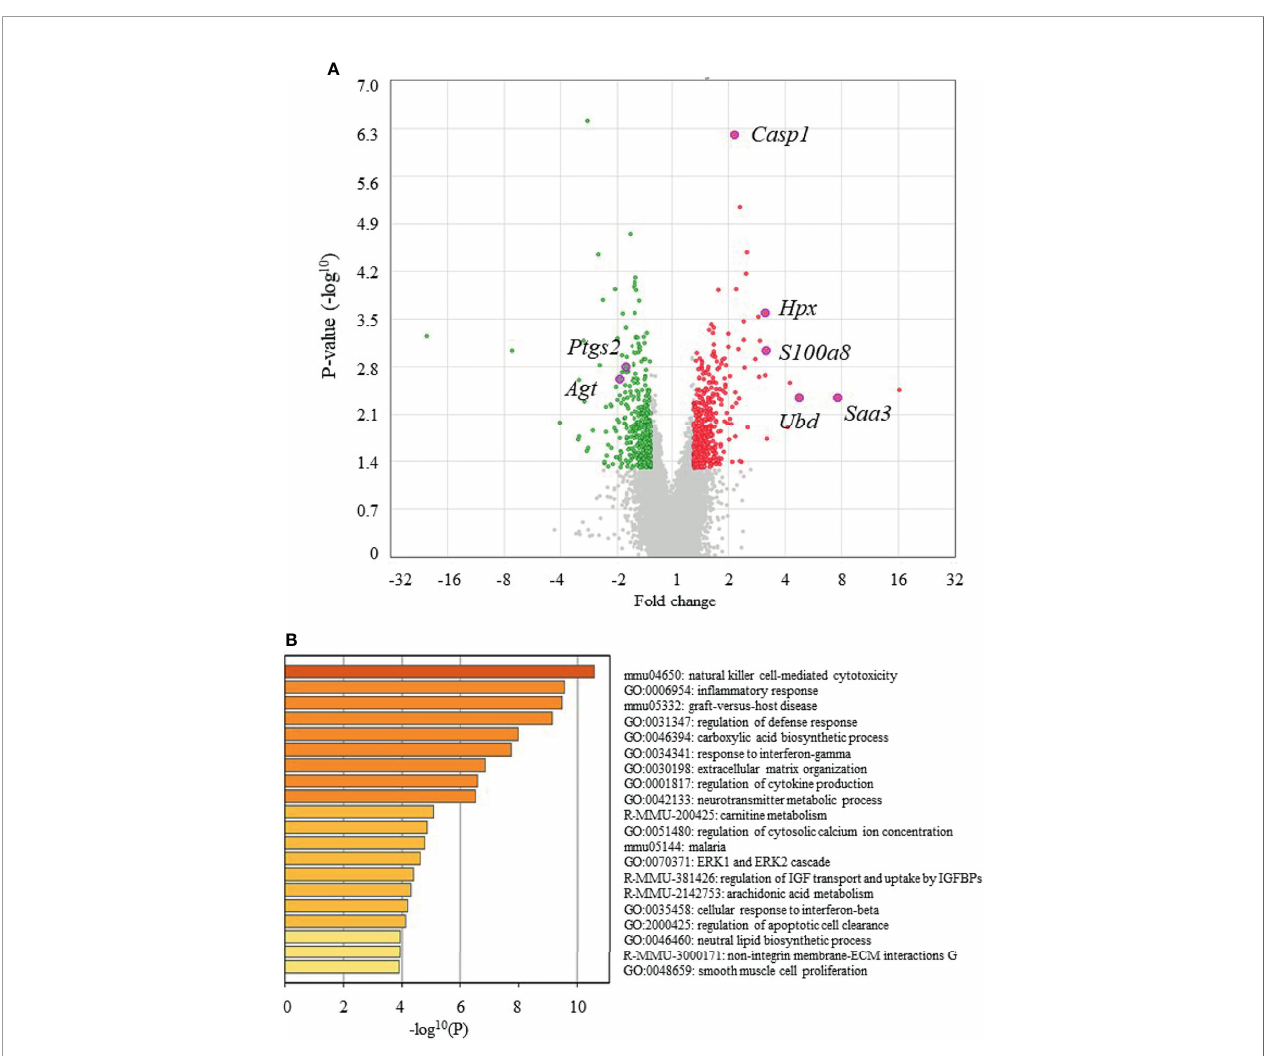
FIGURE 4 | Volcano plots (A) and gene ontologies (GO) terms from a gene enrichment analysis (B) using microarray data from epididymal adipose tissues of UN- RG-Veh and NN-Veh pups (4 each) at 16.5 wks. The names of 7 GOI ( Table 3 ) were plotted in volcano plots (A)